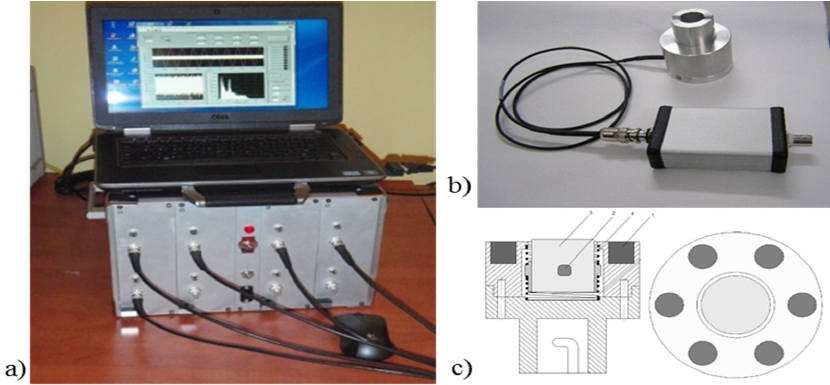
Figure 2. ( a ) The measurement system 8AE-PD; ( b ) the AE sensor in the housing together with the amplifier; ( c ) the construction of the magnetic holder.